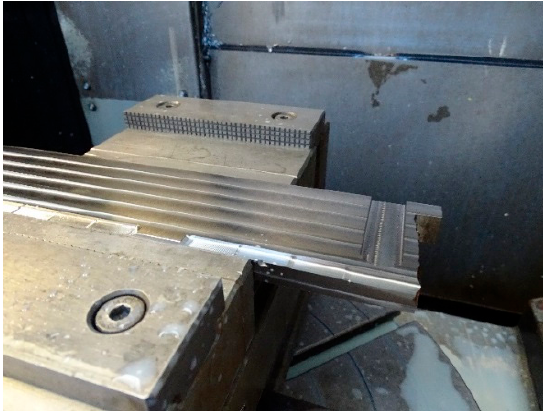
Figure 15. Slot milling across the PAW-WAAM wall.